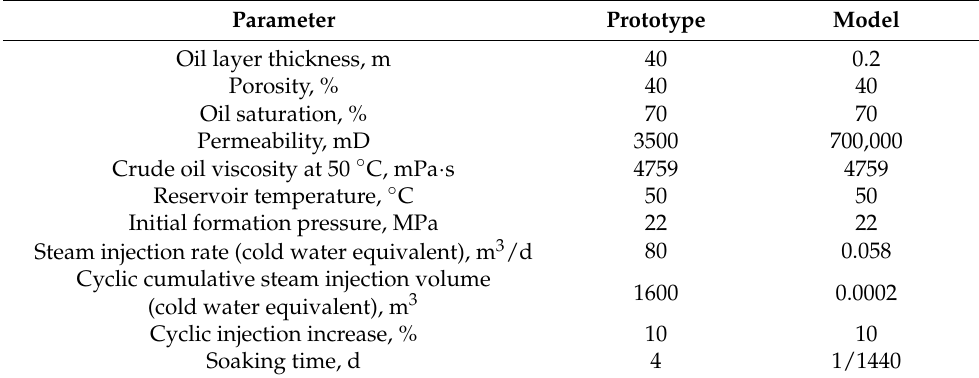
Table 2. Parameter conversion of oil reservoir prototype and scale model.